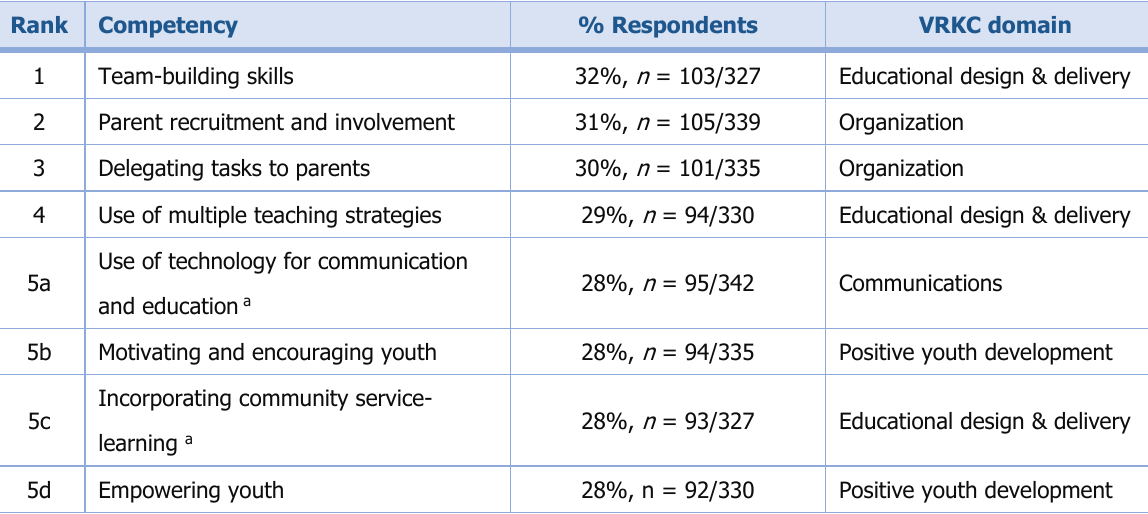
Table 2. Top Five Competencies Volunteers Want to Know More About